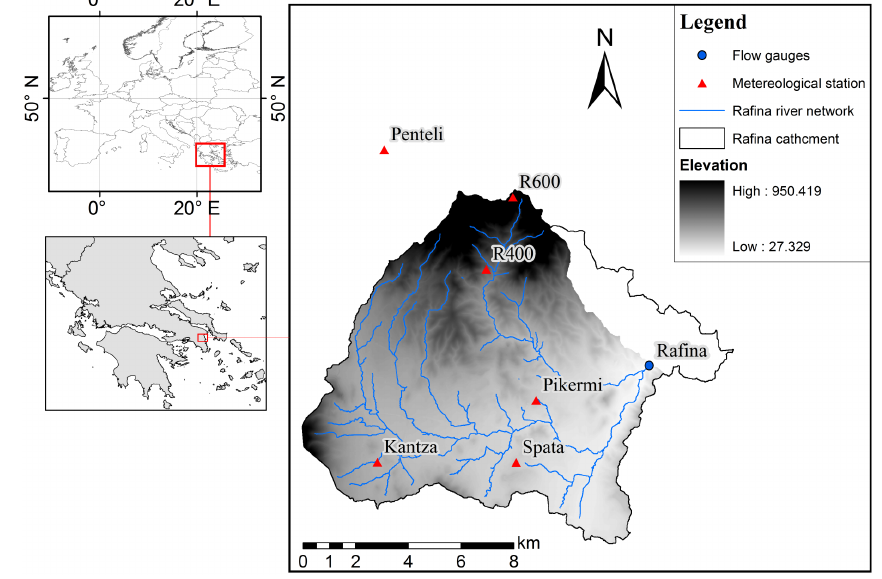
Fig. 1. Study area and locations of meteorological and runoff gauges stations used in the study.